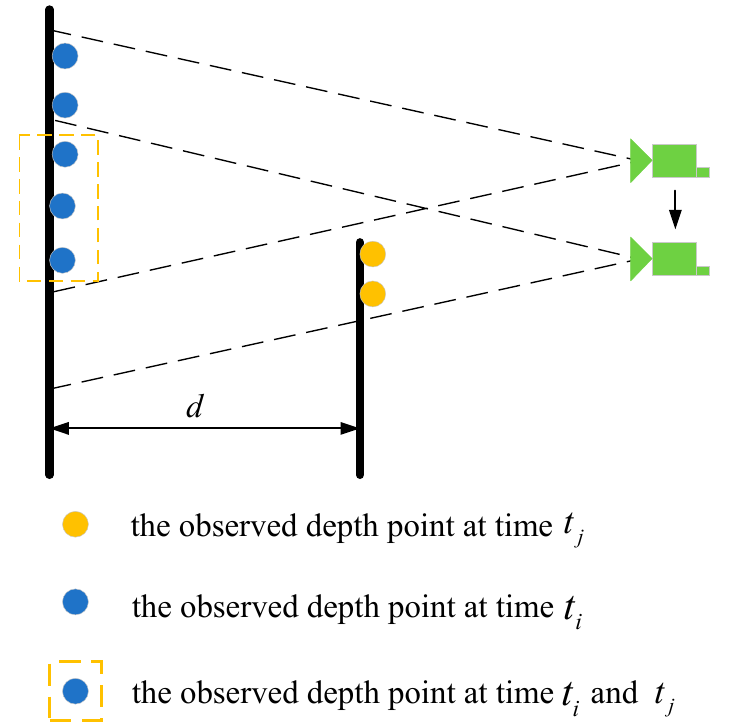
Figure 5. Feature depth validation.